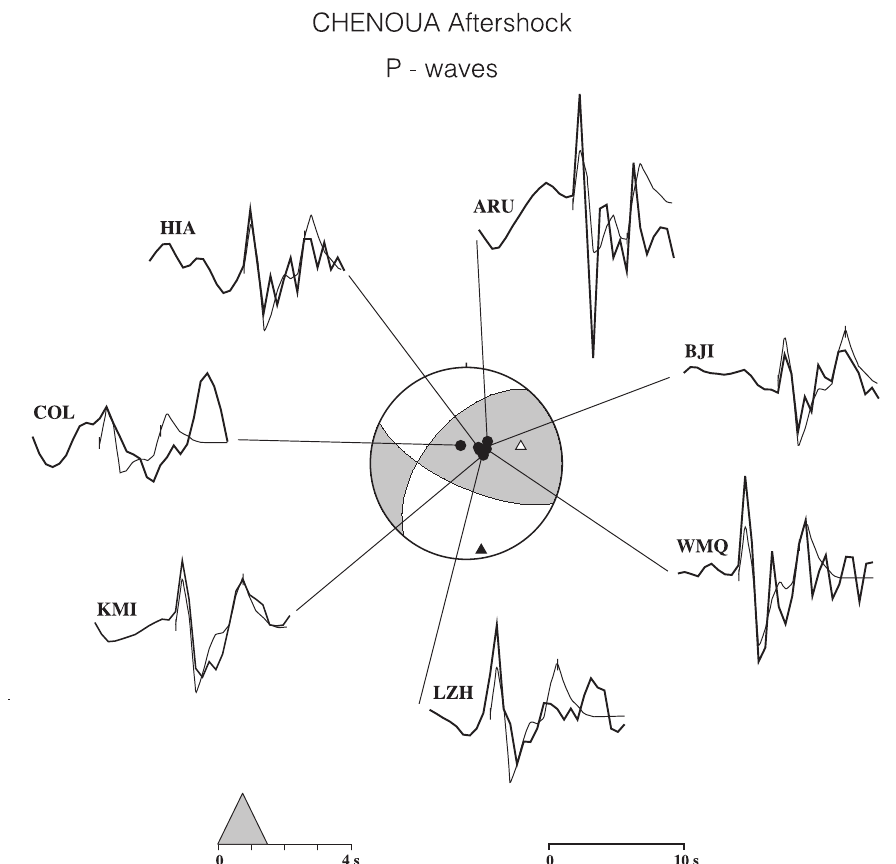
Fig. 4. Comparison between observed BRB and synthetic signals for the large aftershock 10 min after the main shock. Conventions as in fi g.